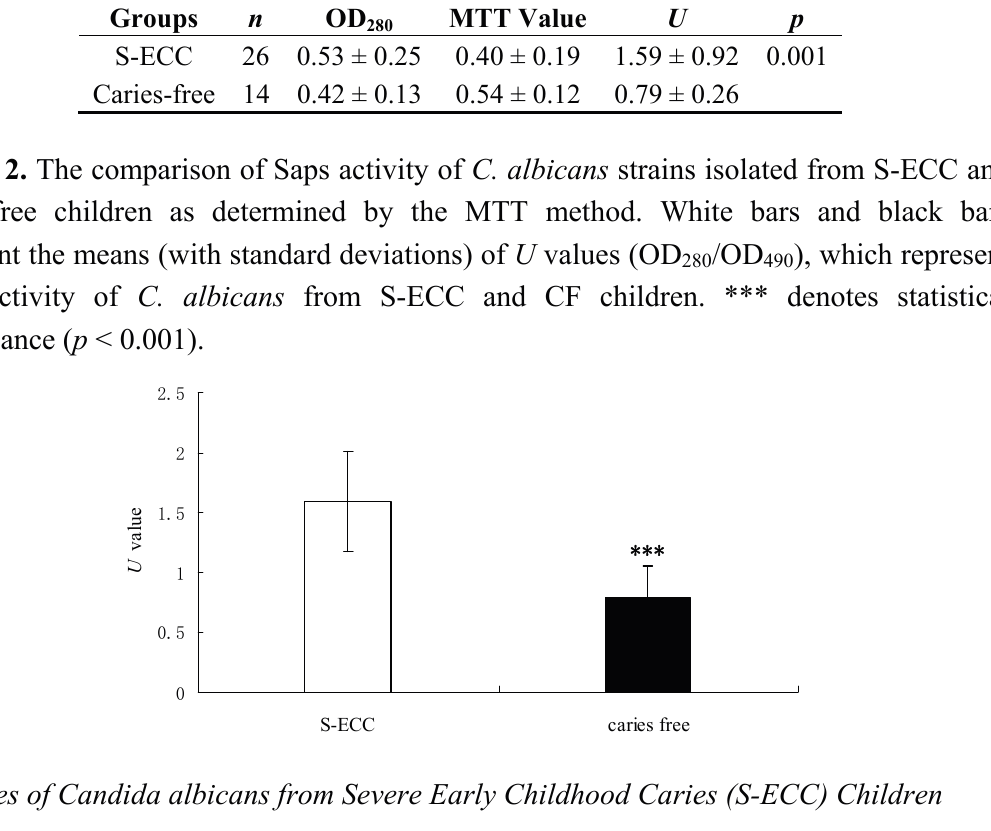
Table 2. Saps activity determined by the bovine serum albumin–MTT (BSA–MTT) method.